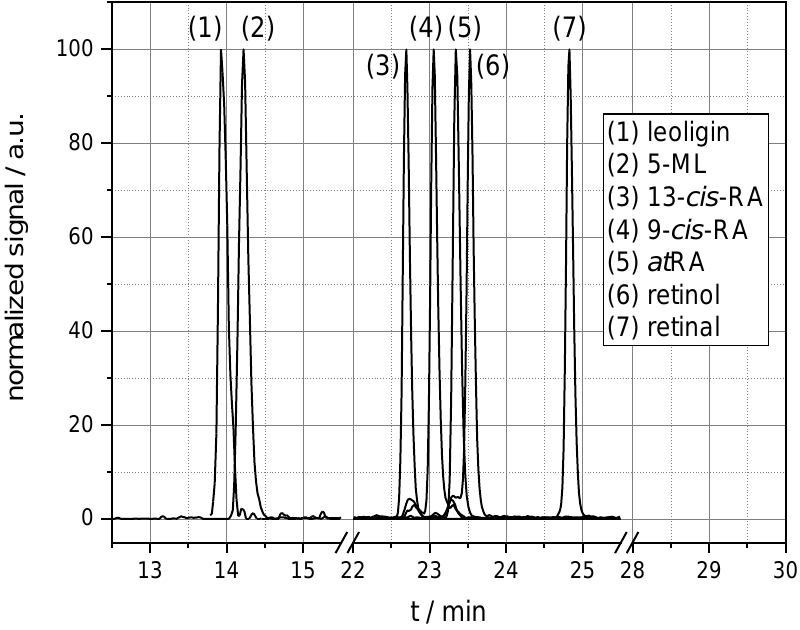
Figure 2. Normalized chromatogram obtained with the high-performance liquid chromatography tandem mass spectrometry (HPLC-MS/MS) method developed.